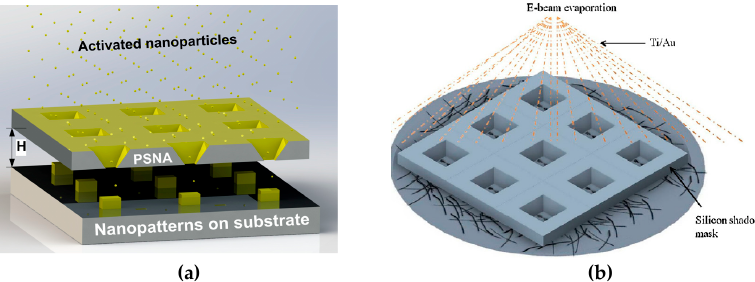
Figure 2. ( a ) Silicon nanostencil mask with pyramidal silicon nanopore arrays (PSNAs). Reprinted with permission from [48]. Copyright (2014), American Chemical Society; ( b ) silicon shadow mask for metallization of single-walled nanotubes (SWNTs). Reprinted from [52], Copyright (2016), with permission from Elsevier.